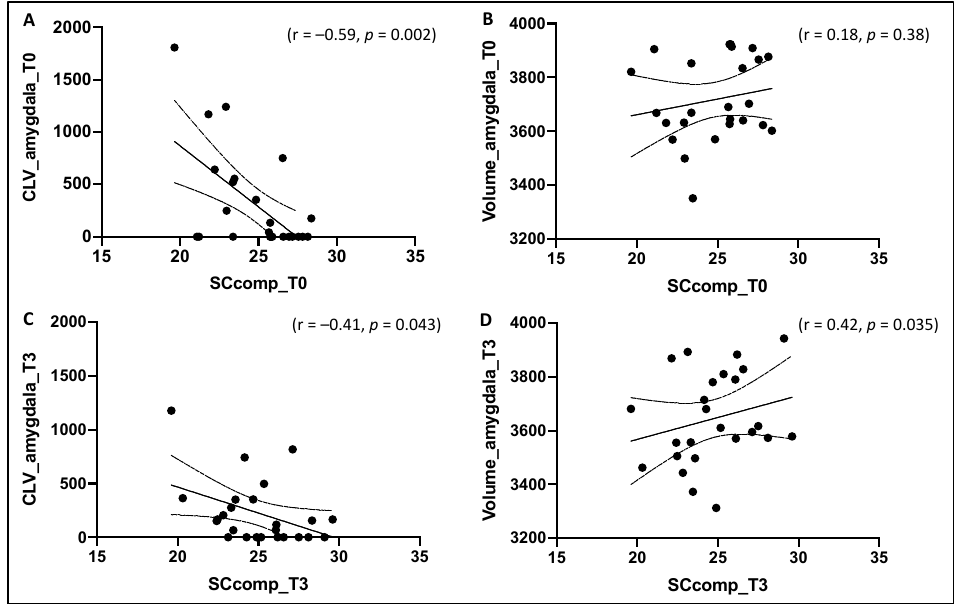
Figure 3. Association between SCcomp and, respectively, amygdala cortical lesion volume (CLV) ( A ) and amygdala volume ( B ) at baseline (T0), and between SCcomp and, respectively, amygdala cortical lesion volume (CLV) ( C ) and amygdala volume ( D ) at follow-up (T3). SCcomp = social cognition composite score.